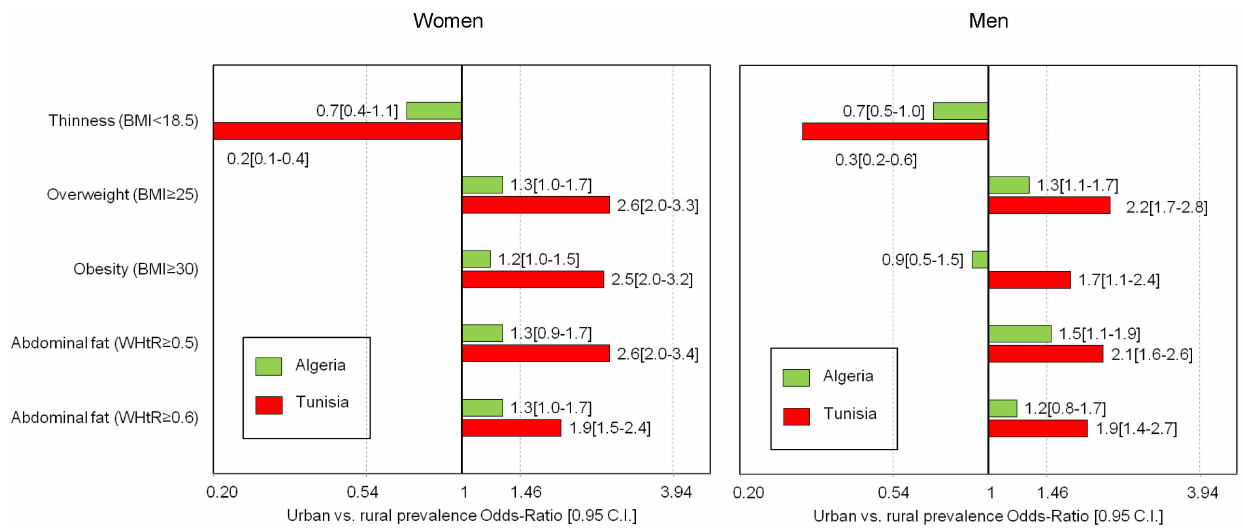
Figure 2. Urban vs. rural contrasts of overall and abdominal adiposity among Algerian and Tunisian 35–70 year old adults, by gender. Urban vs. rural prevalence proportion odd-ratios weighted estimates for overall and abdominal adiposity, by gender and country (Women Algeria: urban n=1735, rural: n=1007; women Tunisia: urban n=1638, rural: n=1326; men Algeria: urban n=1185, rural: n=819; men Tunisia: urban n=1423, rural: n=956). BMI: Body Mass Index in kg/m 2 , WHtR: Waist (cm) to Height (cm) Ratio. C.I.: 0.95 confidence interval adjusted for sampling design.